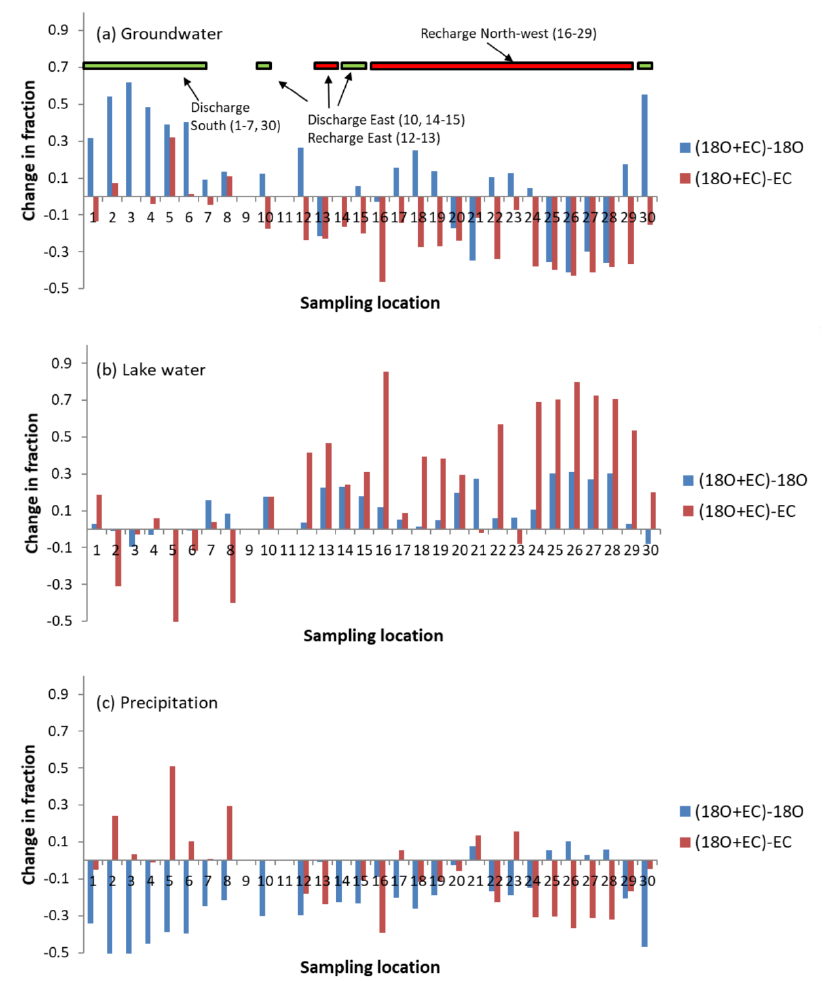
Figure 11. Change in mixing fractions of the sample (i.e., fraction using dual tracer minus fraction using single tracer) coming from ( a ) groundwater, ( b ) lake water, and ( c ) precipitation based on a mixing analysis using both EC and δ 18 O, only δ 18 O, and only EC. The green line shows the segments, where discharge is the major fraction and the red line shows the segments, where recharge is the major fraction. Samples 9 and 11 were not included. Based on data from February 2016.